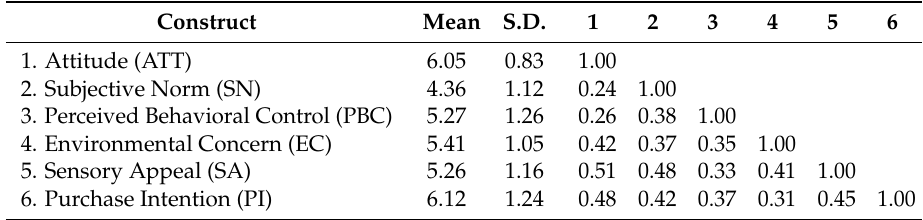
Table 4. Means, standard deviations and correlations of